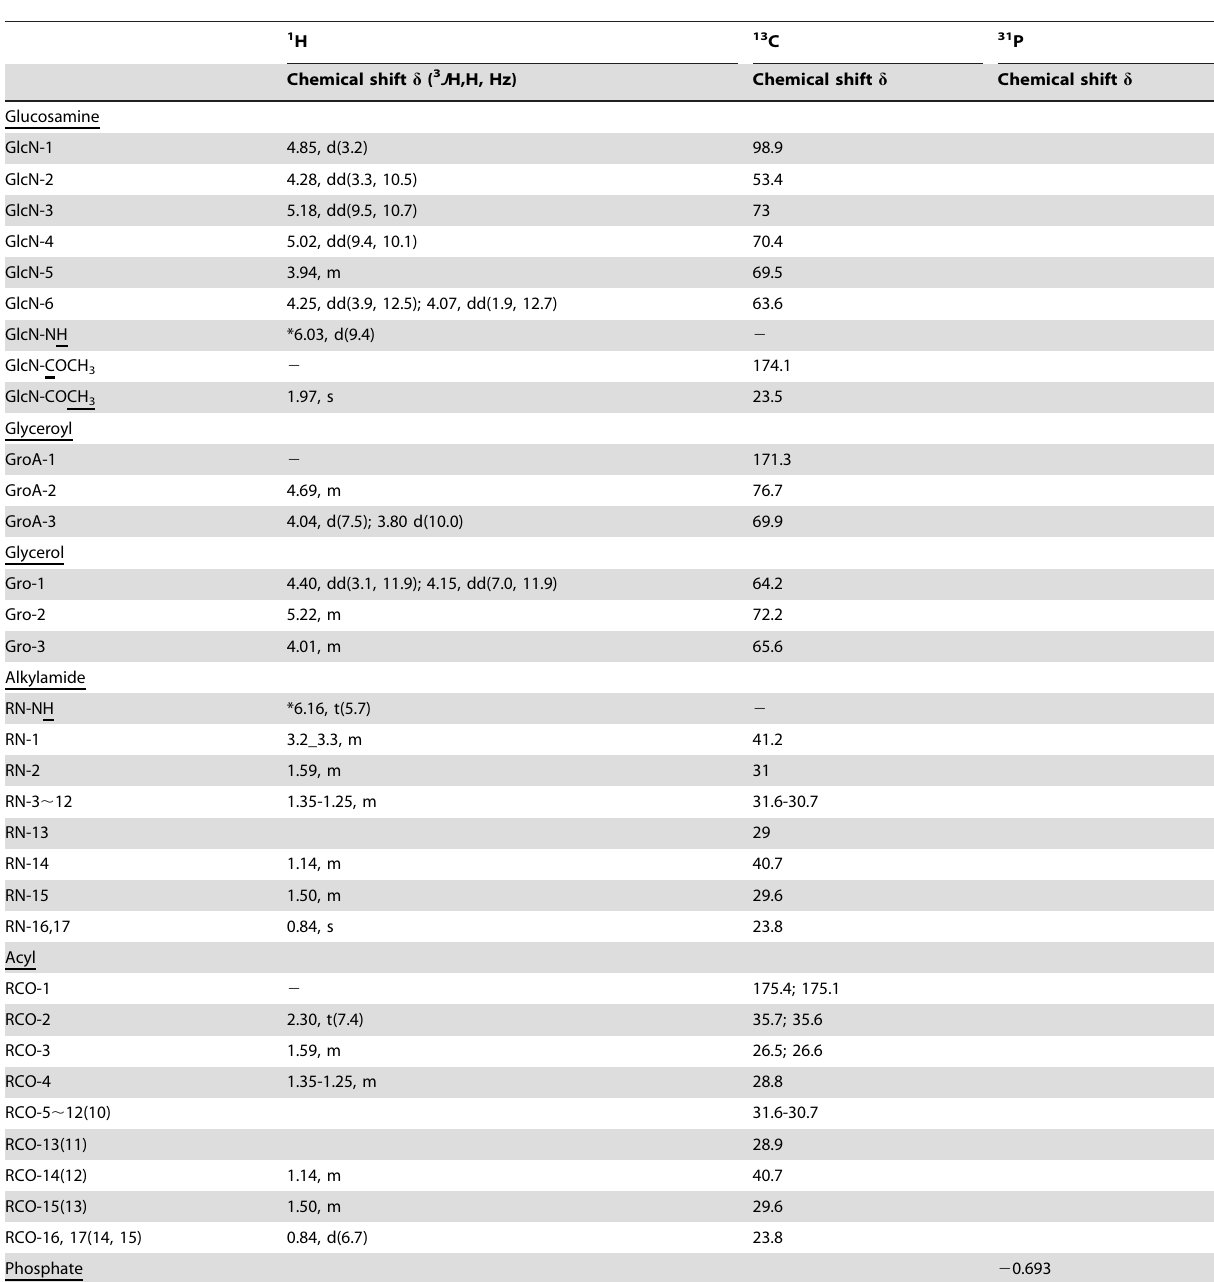
Table 5. NMR data of per-acetylated acidic glycolipid (AGL-B) from T. thermophilus